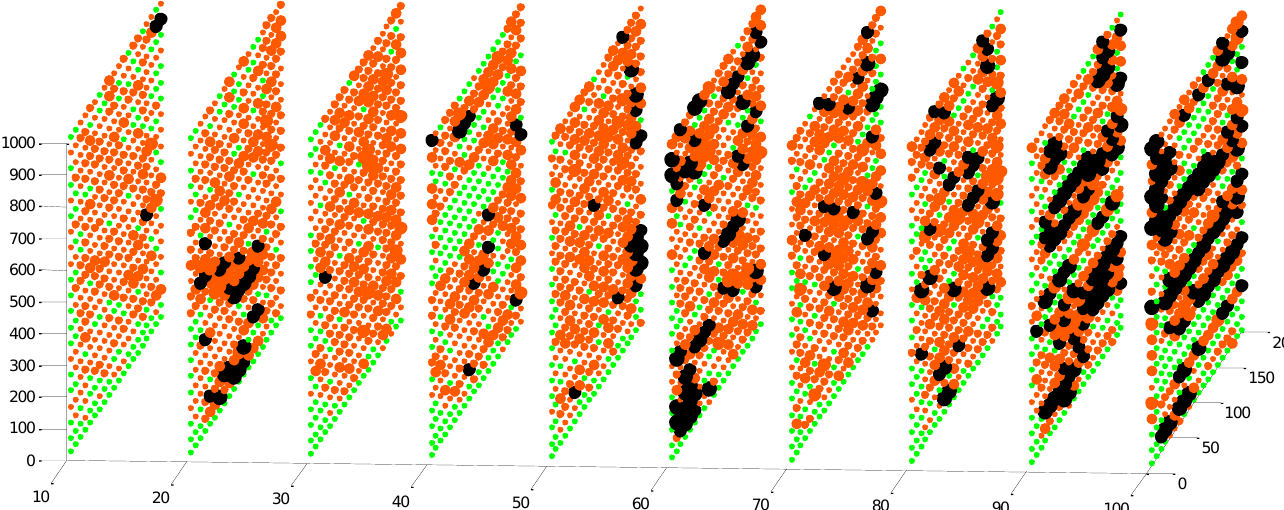
c on EEACL26 images roughly similar to Fig. 8. Performance 32